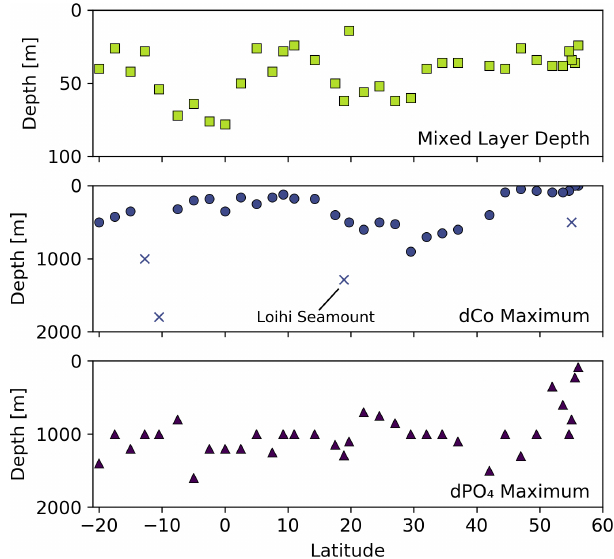
Figure 6. Mixed-layer depth, depth of the dCo maximum and depth of the dPO 4 maximum vs. latitude for the GP15 transect. Outlier dCo maxima depths are indicated with an